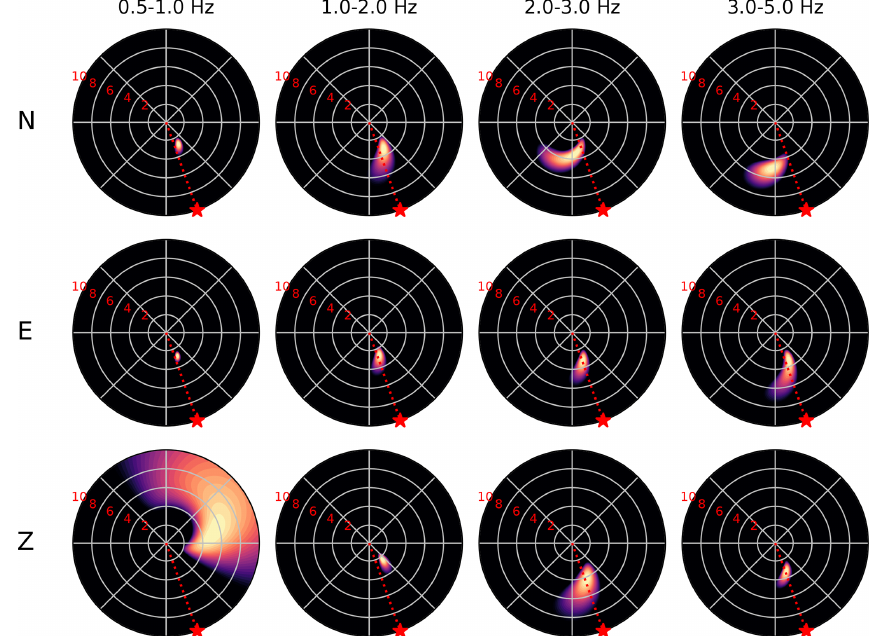
Figure 5. Beamforming results of the S waves recorded by the nodal array. The panel representation is the same as in Fig. 4.